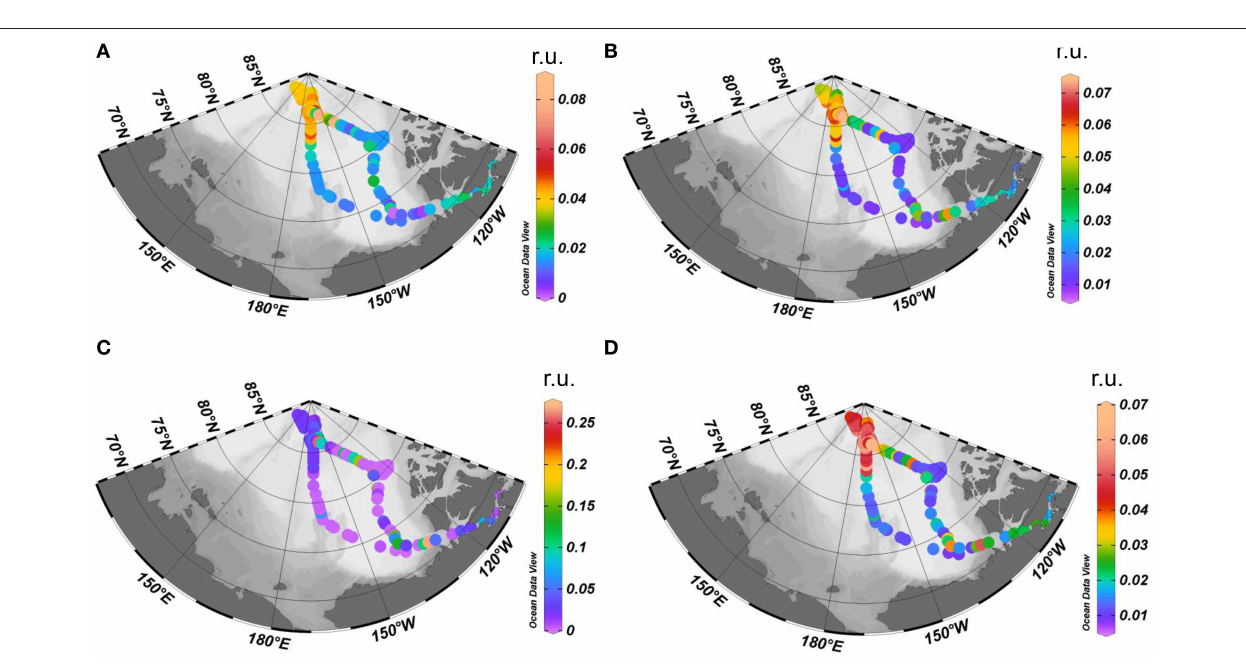
FIGURE 5 | Spatial distributions of (A–D) humic-like